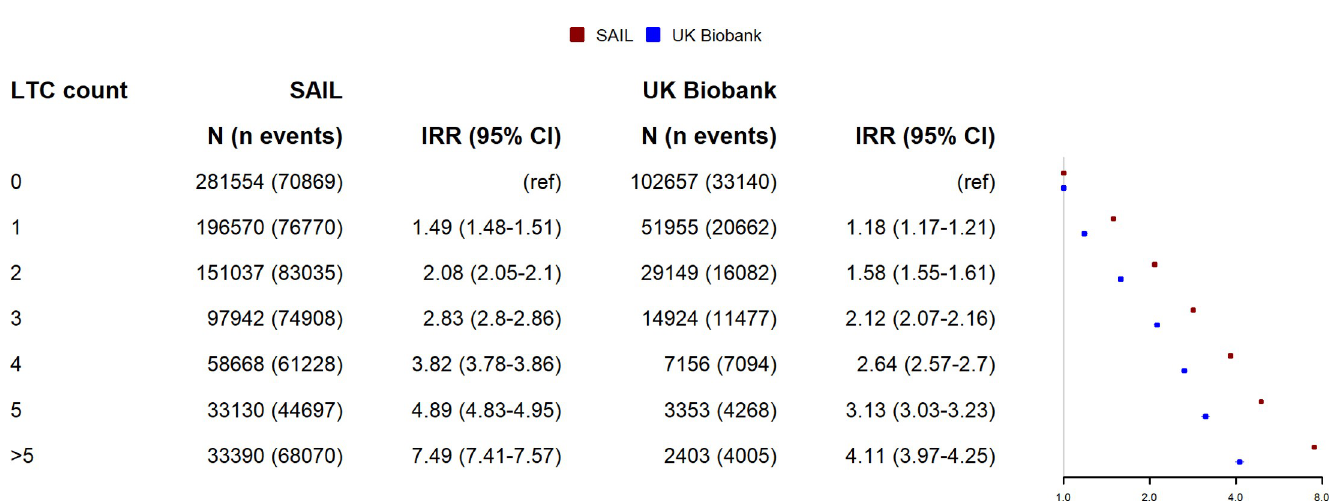
Fig 6. Relationship between LTC count and IRR for unscheduled hospitalisation in UK Biobank and SAIL. Points indicate IRRs adjusted for age, sex, and socioeconomic status. Whiskers indicate 95% CIs. N = total number of participants per LTC count, n events = number of events. CI, confidence interval; IRR, incidence rate ratio; LTC, long-term condition; SAIL, Secure Anonymised Information Linkage.